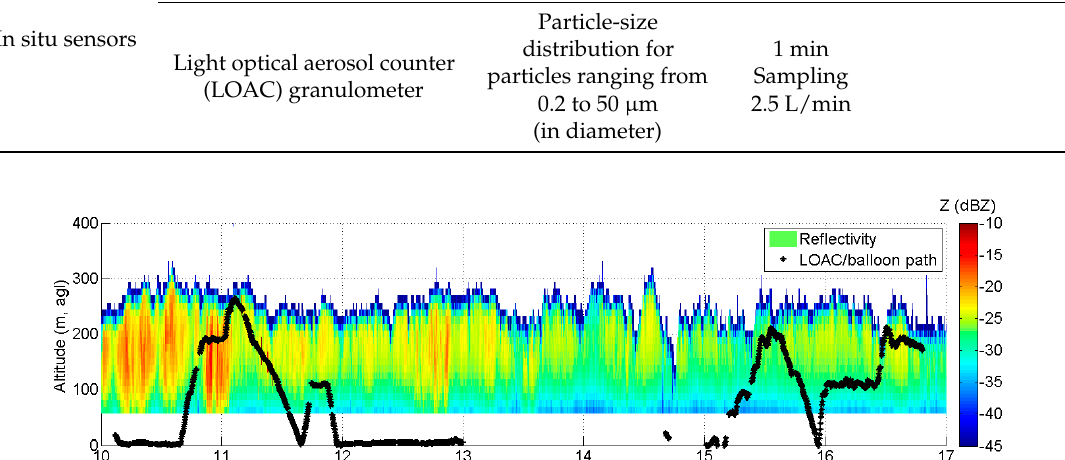
Figure 1. Cloud radar reflectivity and tethered balloon path on 3 January